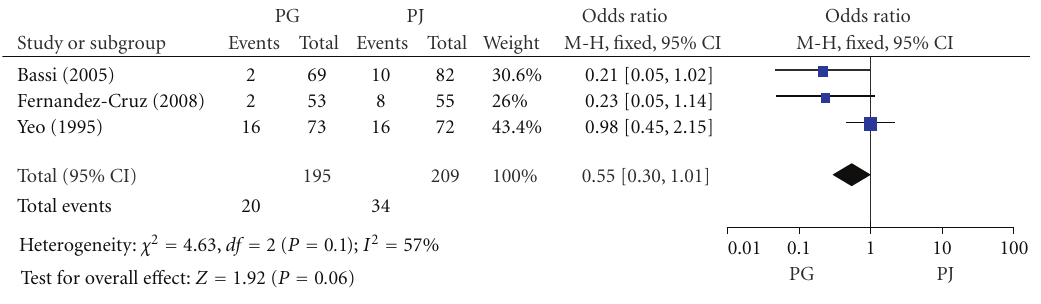
Figure 7: Forest plot of delayed gastric emptying between PG and